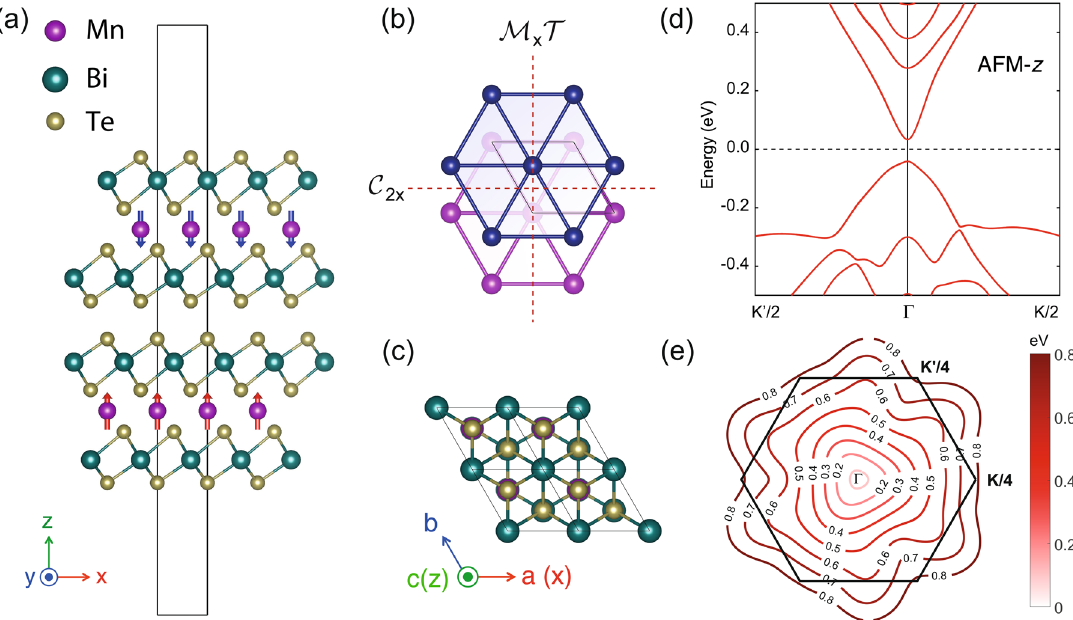
Fig. 1 Crystal structure and electronic structure of bilayer AFM- z MnBi2Te4. a – c The side and top view of bilayer AFM- z MnBi 2 Te 4 . b Selected magnetic symmetry elements in bilayer AFM- z MnBi 2 Te 4 with the corresponding point group of 3 0 m 0 in international notation or D 3 d ð D 3 Þ in Schoen fl ies notation. Two magnetic symmetry elements are illustrated in the plot, including twofold rotation symmetry around x -axis C 2 x ¼ M y M z , and the combination of mirror symmetry and time-reversal symmetry M x T . d Electronic band structure of bilayer AFM- z MnBi 2 Te 4 near the Fermi level. e Contour plot of the energy difference between bottom conduction band and top valence